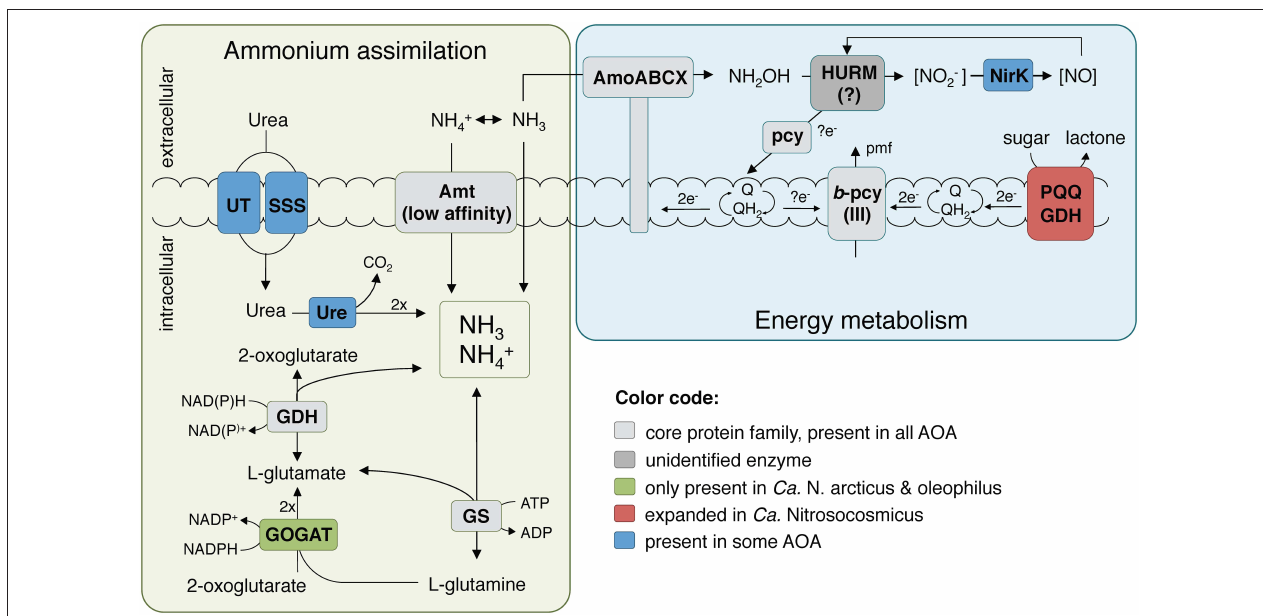
FIGURE 6 | Reconstruction of the putative energy metabolism and primary nitrogen assimilation pathways in Ca. N. arcticus Kfb. The ammonia oxidation pathway representation was adapted from Kozlowski et al. (2016), Abbreviations: AMO, ammonia monooxygenase; Amt, ammonium transporter family; GDH, glutamate dehydrogenase; GOGAT, glutamate synthase; GS, glutamine synthetase; HURM, putative hydroxylamine:ubiquinone redox module; NirK, Cu-containing nitrite reductase; pcy, plastocyanin; pmf, proton-motive force; PQQ GDH, PQQ-dependent glucose/sorbosone dehydrogenase; Q/QH 2 , quinone/quinol pool; Ure, urease holoenzyme; UT, urea transporter family; SSS, solute:sodium symporter